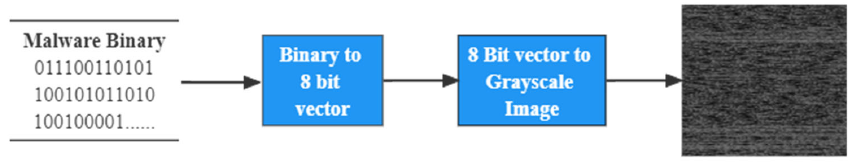
Figure 2. Visualizing malware as an image.